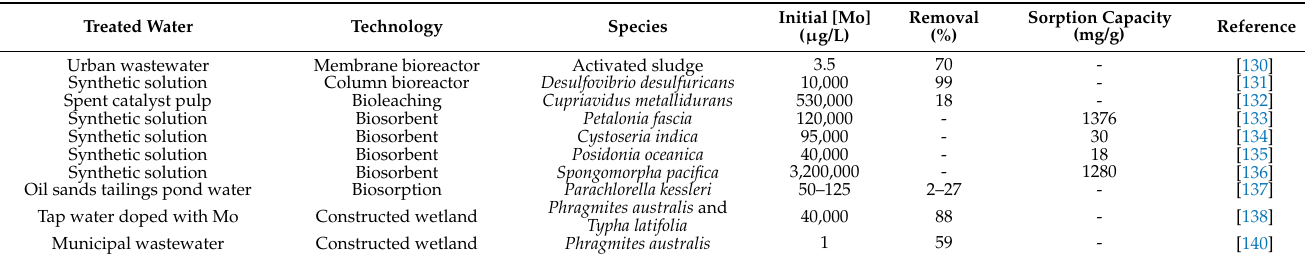
Table 12. Compilation of the main results of the biological treatments applied for molybdenum removal from aqueous